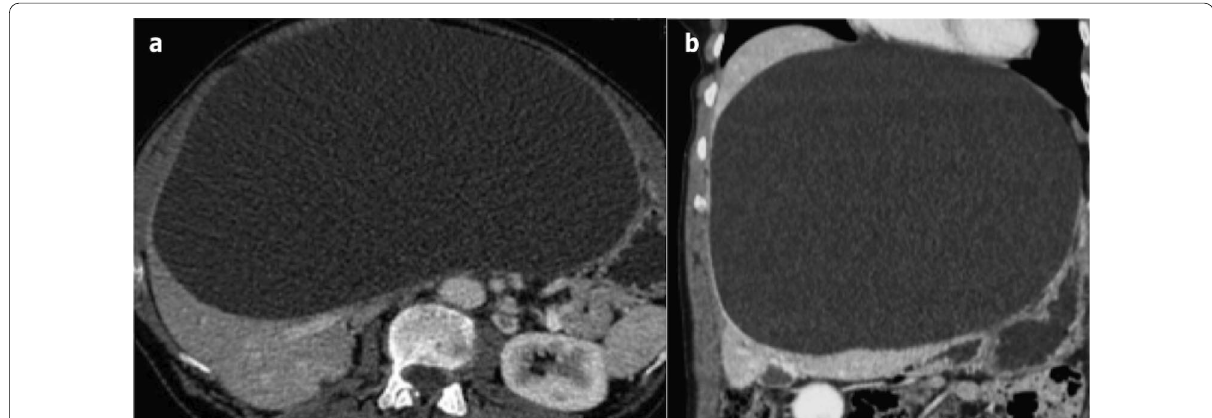
Fig. 4 Very large simple hepatic cyst in a symptomatic 64-year-old female with abdominal pain. a Axial and ( b ) coronal computed tomography on portal venous phase shows a very large simple hepatic cyst. The cyst had grown progressively for a certain number of years and was eventually treated by laparoscopic fenestration, resulting in pain relief